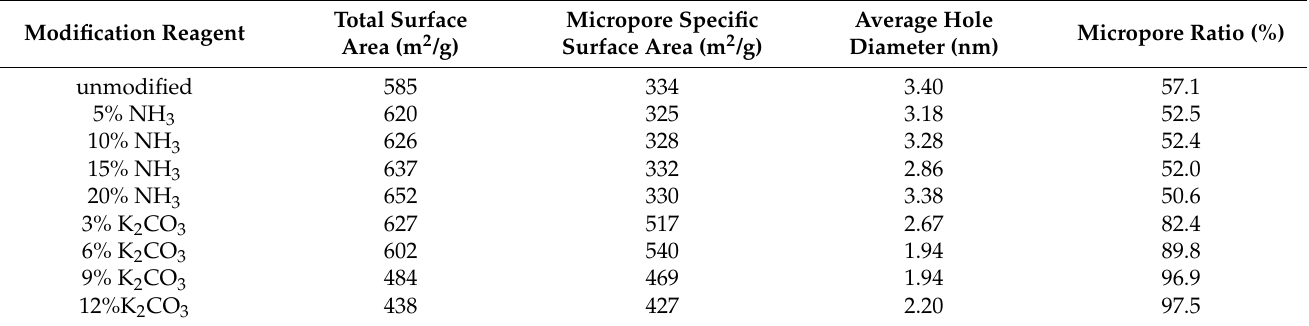
Table 1. Physical properties of modified activated coke [5].